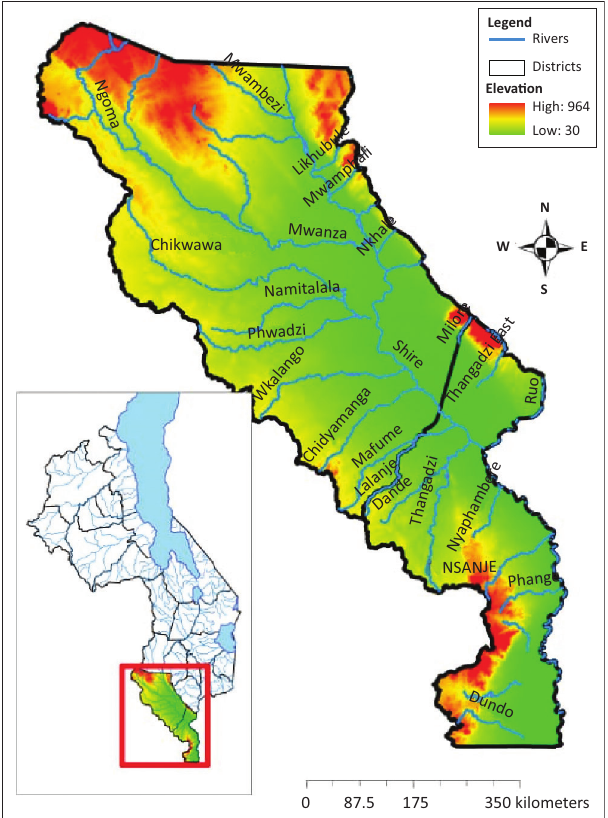
FIGURE 4: Map showing study